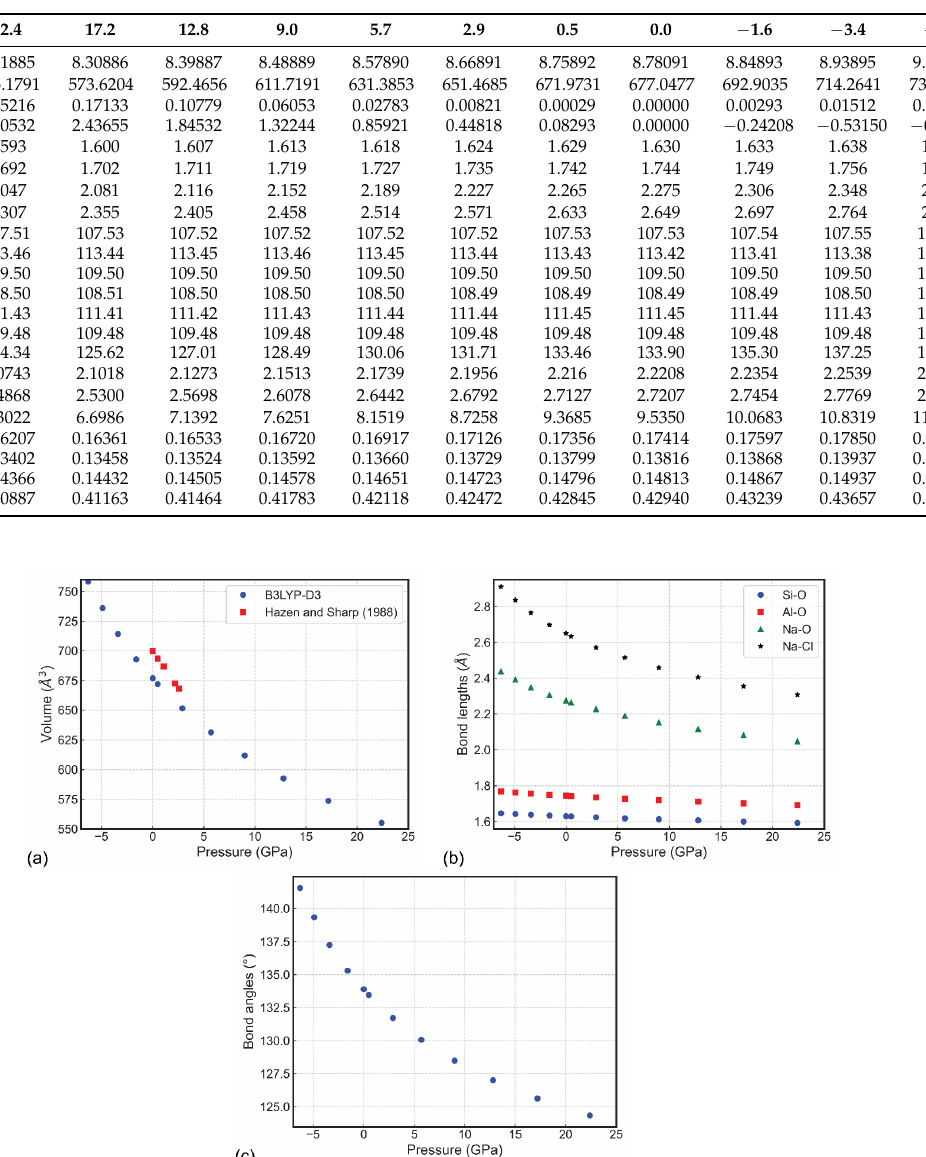
Table 2. Unit cell volume V , lattice parameter a , differences in internal energy ( ∆ U ) and enthalpy ( ∆ H ) with respect to the equilibrium geometry (0 GPa), mean bond lengths and angles, polyhedron volume of SiO 4 and AlO 4 tetrahedra and position of the sodium and oxygen atoms as a function of pressure.